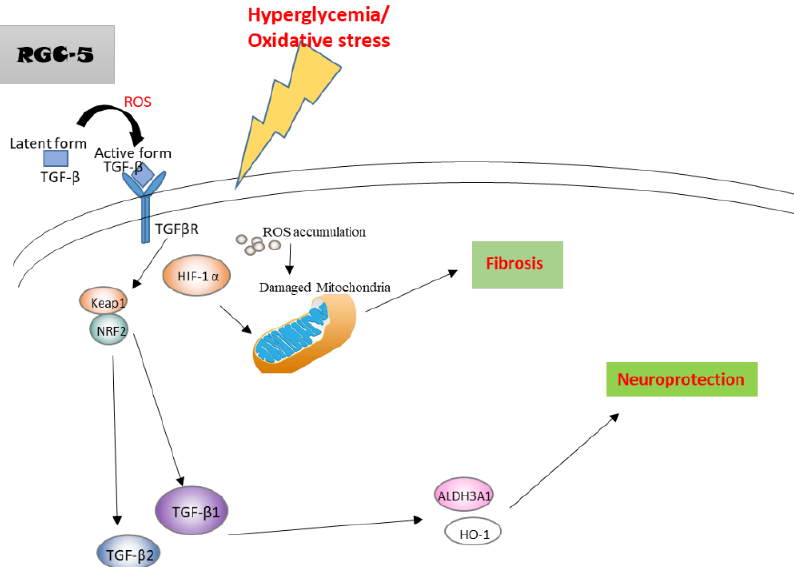
Figure 10. A hypothetical model detailing the role of TGF-β in hyperglycemia.